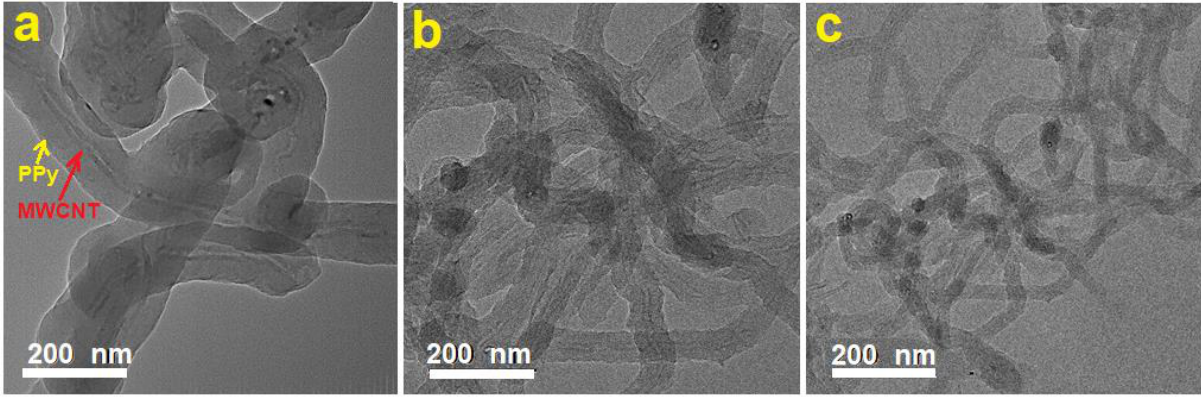
Figure 4. Typical TEM images at the same magnification of MWCNTs/PPy nanocomposites ( a : PN1, b : PN3, c : PN5).